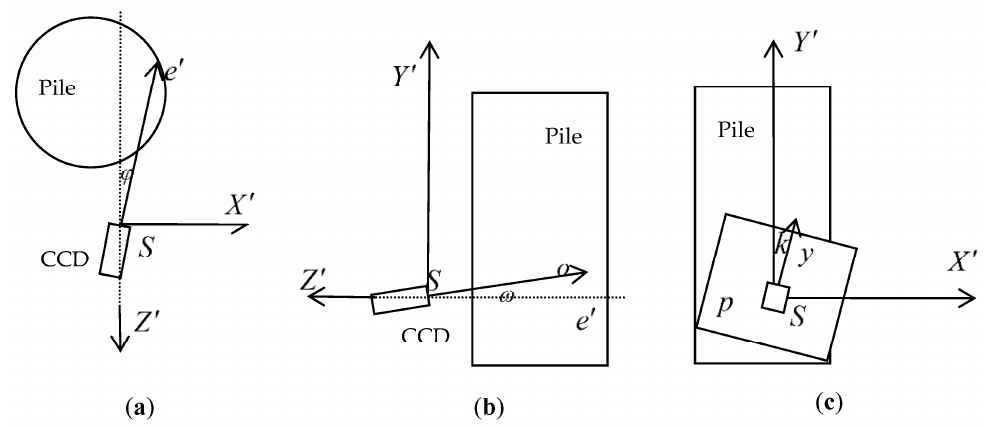
Figure 8. Three exterior orientation angle elements of the CCD camera. ( a ) Vertical view-angle ϕ ; ( b ) Side view-angle ω ; ( c ) Front view-angle k .